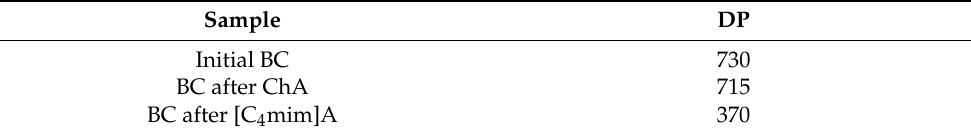
Table 1. Degree of polymerization (DP) of the initial BC and after regeneration from mILs. Sample DP Initial